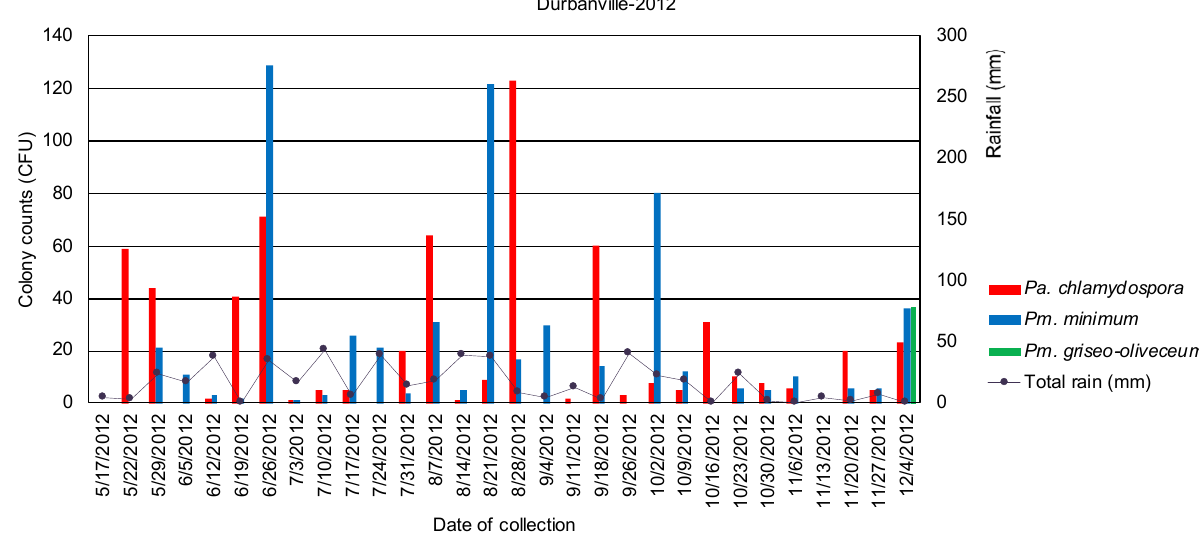
Figure 9. Phaeomoniella and Phaeoacremonium spp. cfu cultured from five vaseline coated microscope slides affixed to the cordons on each of five vines in a vineyard in Durbanville, Western Cape province in 2012. The slides were replaced weekly. Each bar represents the total number of cfu cultured on three Petri